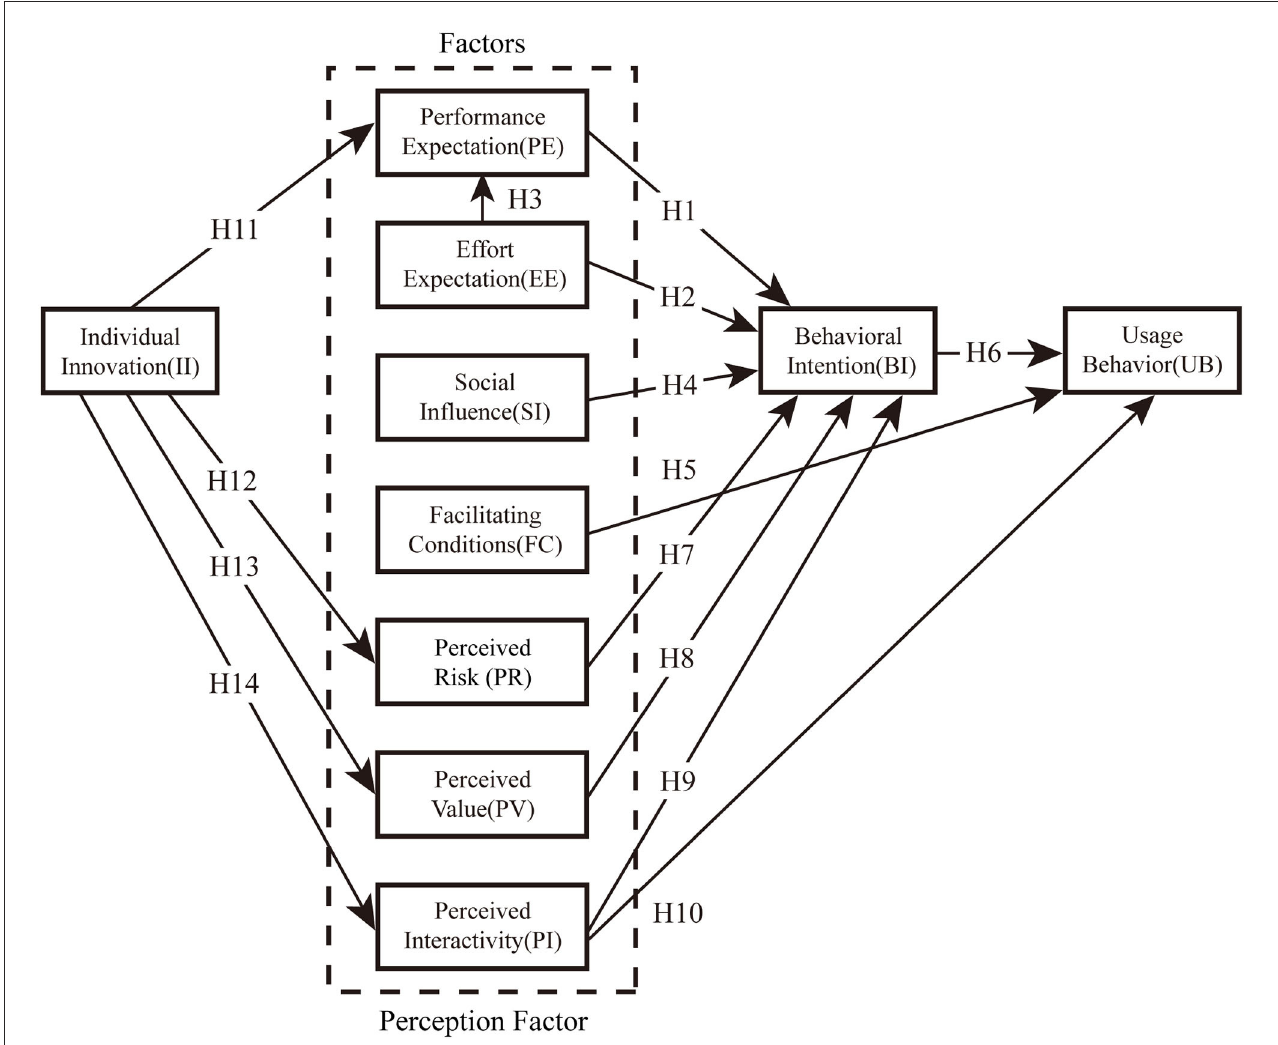
FIGURE1 The proposed research